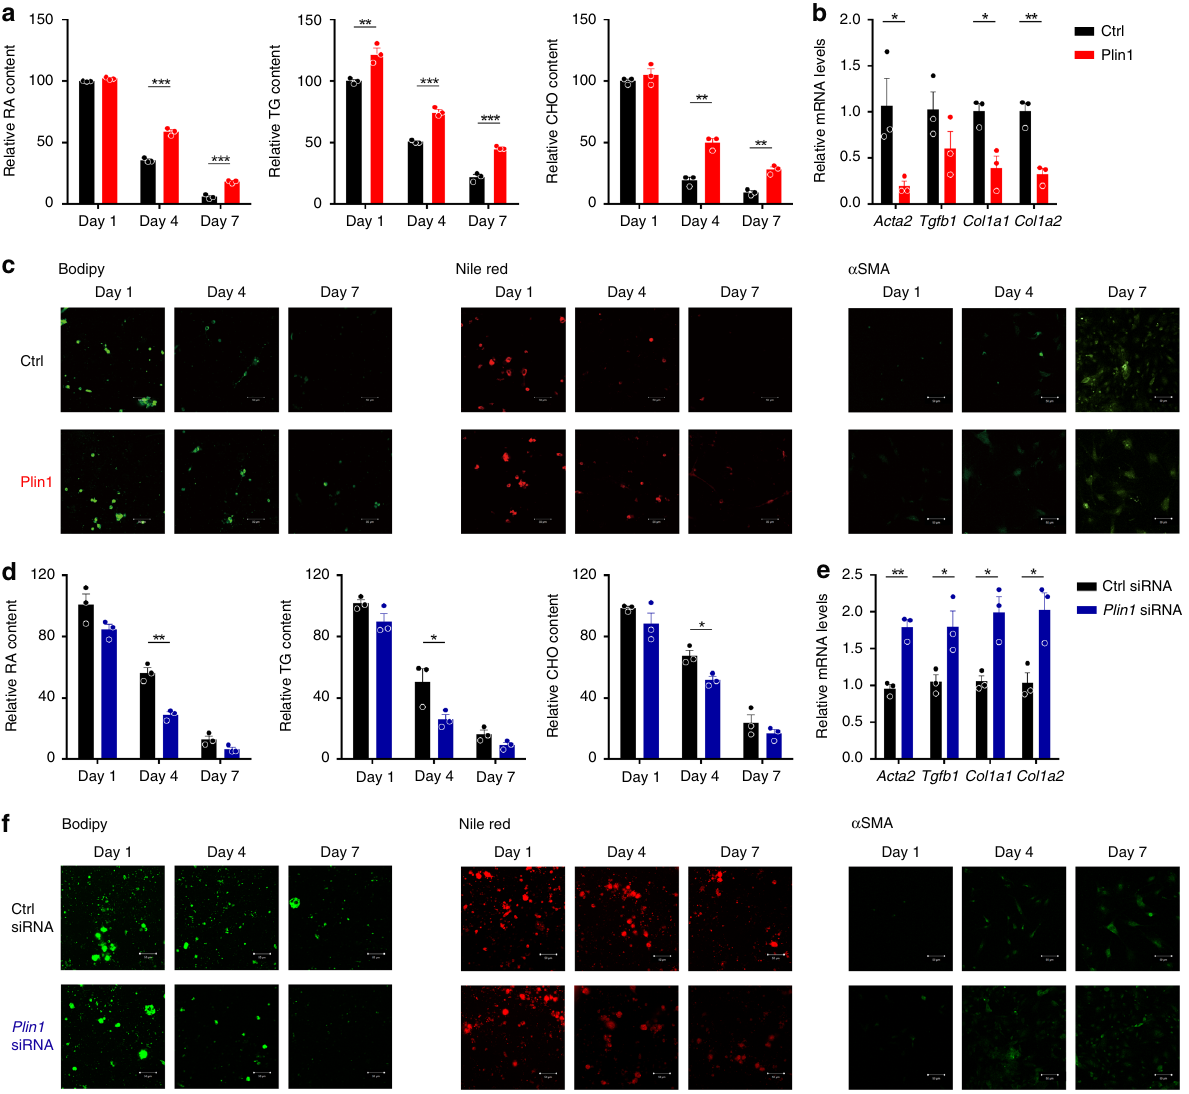
Fig. 8 LD stabilization by Plin1 prevents HSC activation. a – c Plin1 overexpression precluded LD loss and HSC activation ( n = 3 biologically independent samples within these experiments). a Lipids quantitation. b mRNA expression of pro- fi brotic genes. c Bodipy, Nile red, and α -SMA staining of cells (representative of n = 3 biologically independent samples). d – f Plin1 knock-down aggravated LD loss and HSC activation ( n = 3 biologically independent samples within these experiments). d Lipids quantitation. e Pro- fi brotic gene mRNA levels. f Bodipy, Nile red, and α -SMA staining of cells (representative of n = 3 biologically independent samples. Scale bar, 50 μ m). Results are mean ± SEM, * P < 0.05, ** P < 0.01, as assessed with Student ’ s t -test or